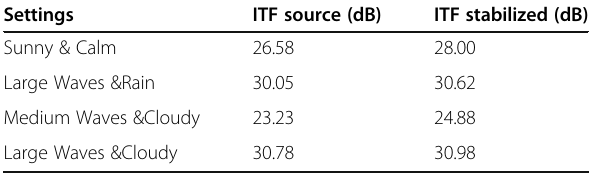
Table 1 Values of ITF for videos under different conditions